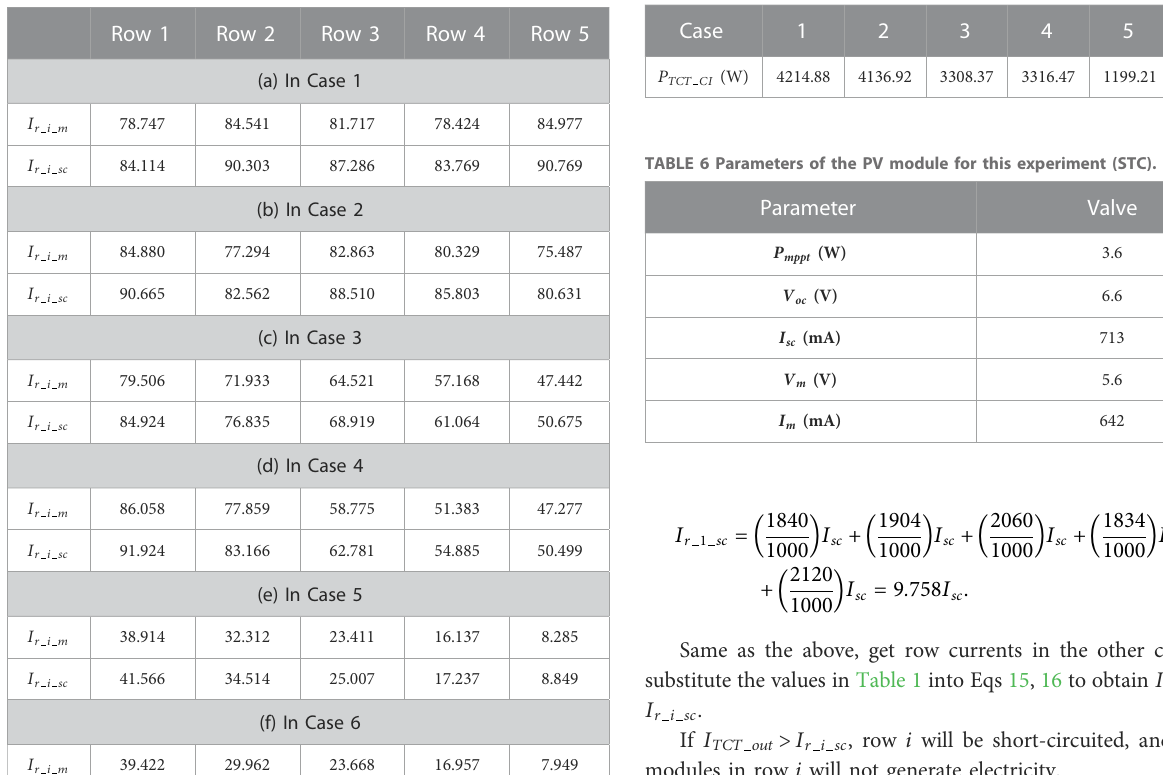
TABLE 5 Estimation of the TCT-CI PV array.